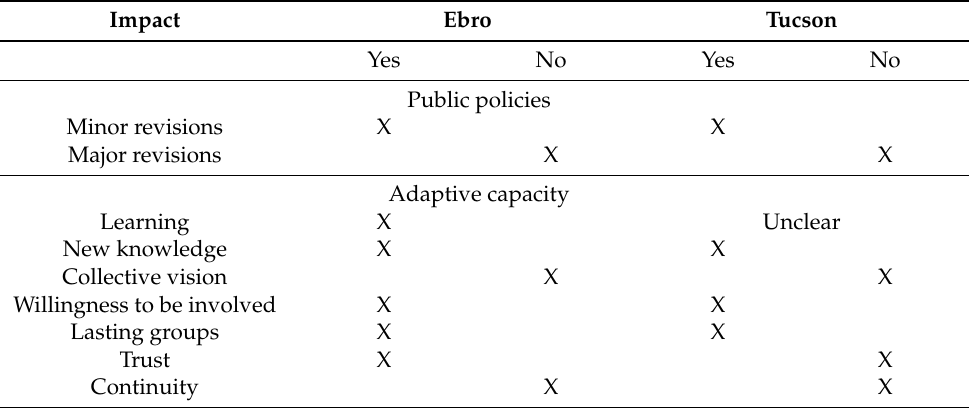
Table 8. Impacts of public participation on public policies and adaptive